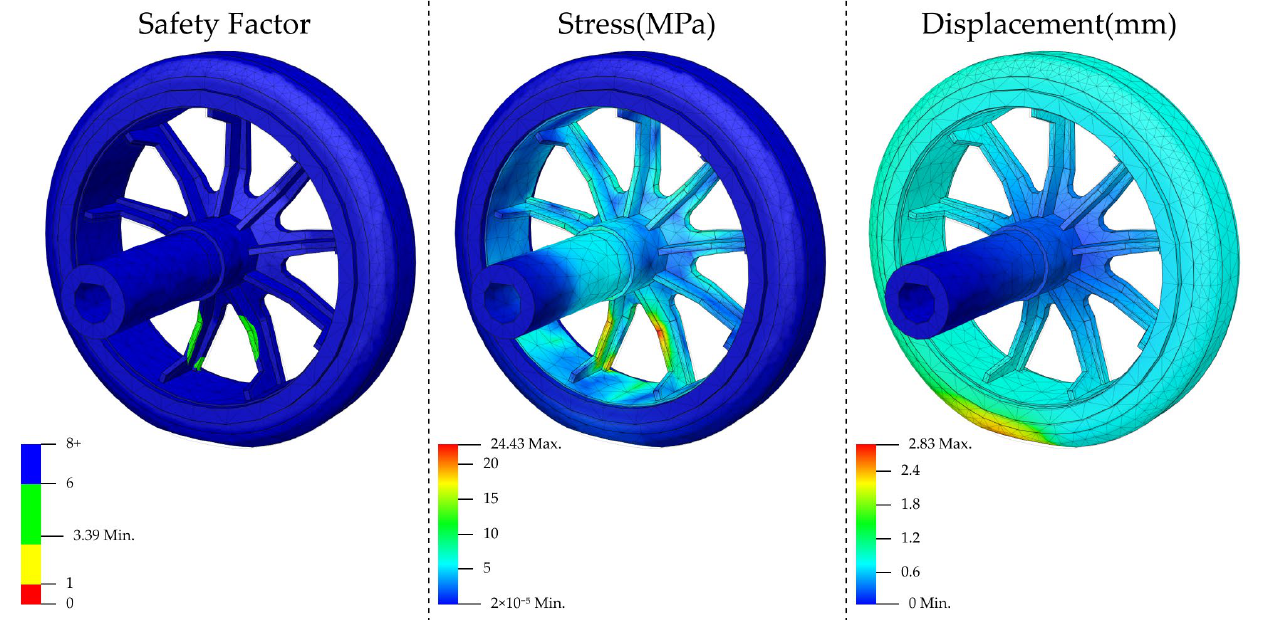
Figure 19. Drive wheel analysis. From left to right are the safety factor, stress, and displacement. Through the analysis and optimization, the thickness, shape, and number of banners of the hub were adjusted. The weight of the hub is only 33 g, and the strength can fully meet the design requirements.